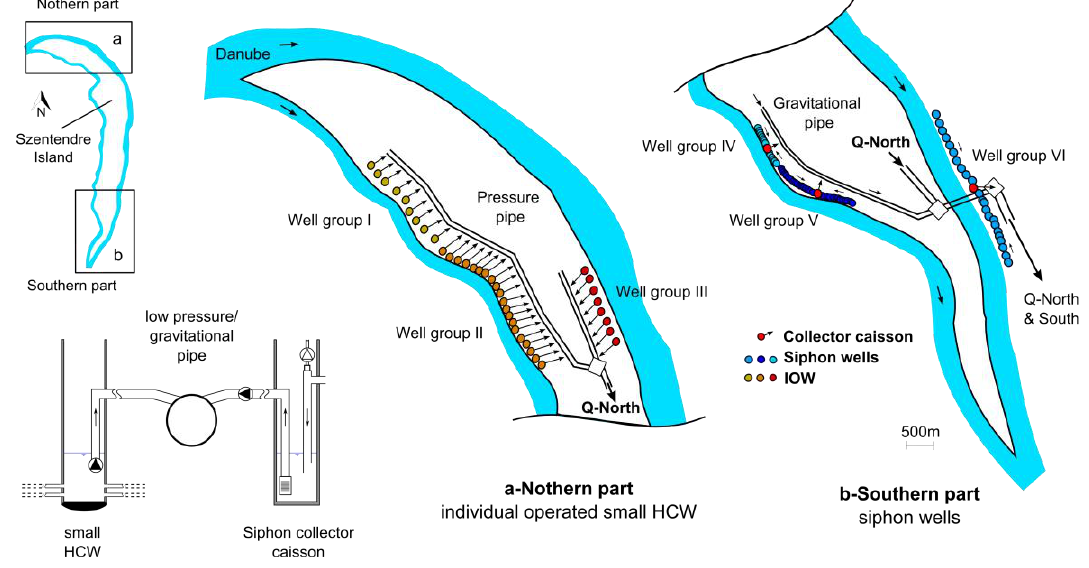
Figure 5. Map of Szentendre Island with approximate location of selected well groups. Table 2. Well design parameters Szentendre Island, Hungary.